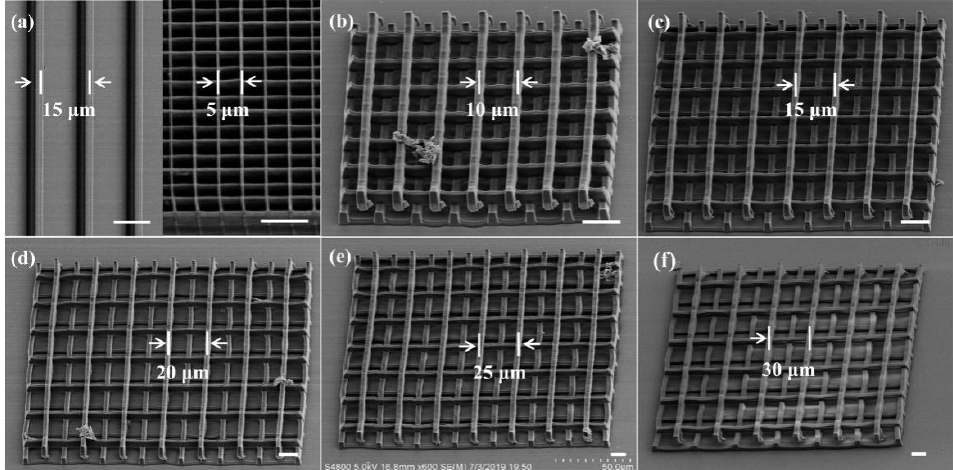
Figure 4. SEM images of different microstructures. ( a ) Hydrogel line array (left) and ST scaffold (right). ( b – f ) Series of the 3D microscaffolds with different strut spacings of 10 μ m, 15 μ m, 20 μ m, (right). ( b – f ) A series of the 3D microscaffolds with different strut spacings of 10 µ m, 15 µ m, 20 25 μ m, and 30 μ m, with corresponding porosities of 69.7%, 79.5%, 84.4%, 87.4% and 89.3%, respec- µ m, 25 µ m, and 30 µ m, with corresponding porosities of 69.7%, 79.5%, 84.4%, 87.4% and 89.3%, tively. The scale bar is 10 μ m. respectively. The scale bar is 10 µ